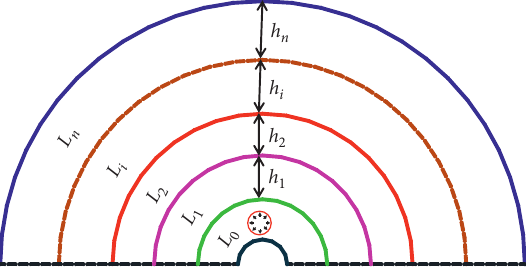
Figure 3: Multilayer elastic half-space system under equivalent elastic load.